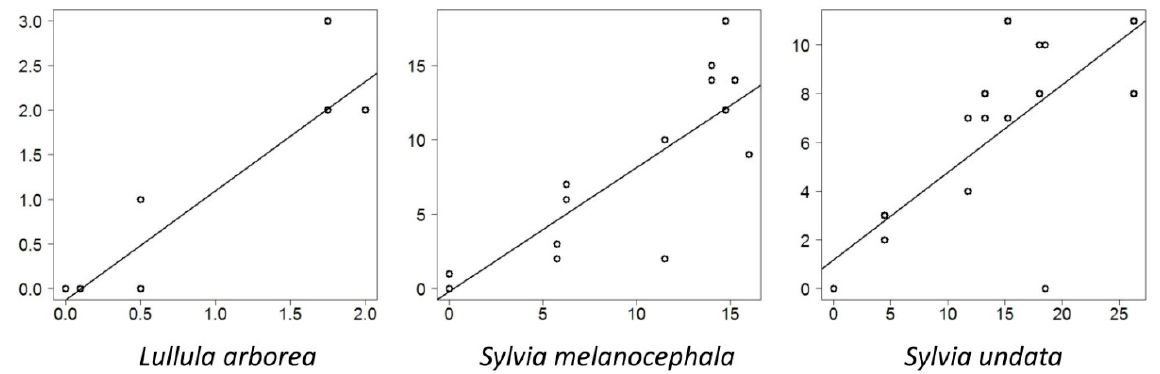
Figure A5. Number of records on transect L (ordinate) as a function of the number of territories on the quadrat (abscissa; in number of pairs per 16 ha), all years 1987–1994 combined. For the warblers, two outliers correspond to particularly poor sampling conditions on the transect in 1991.